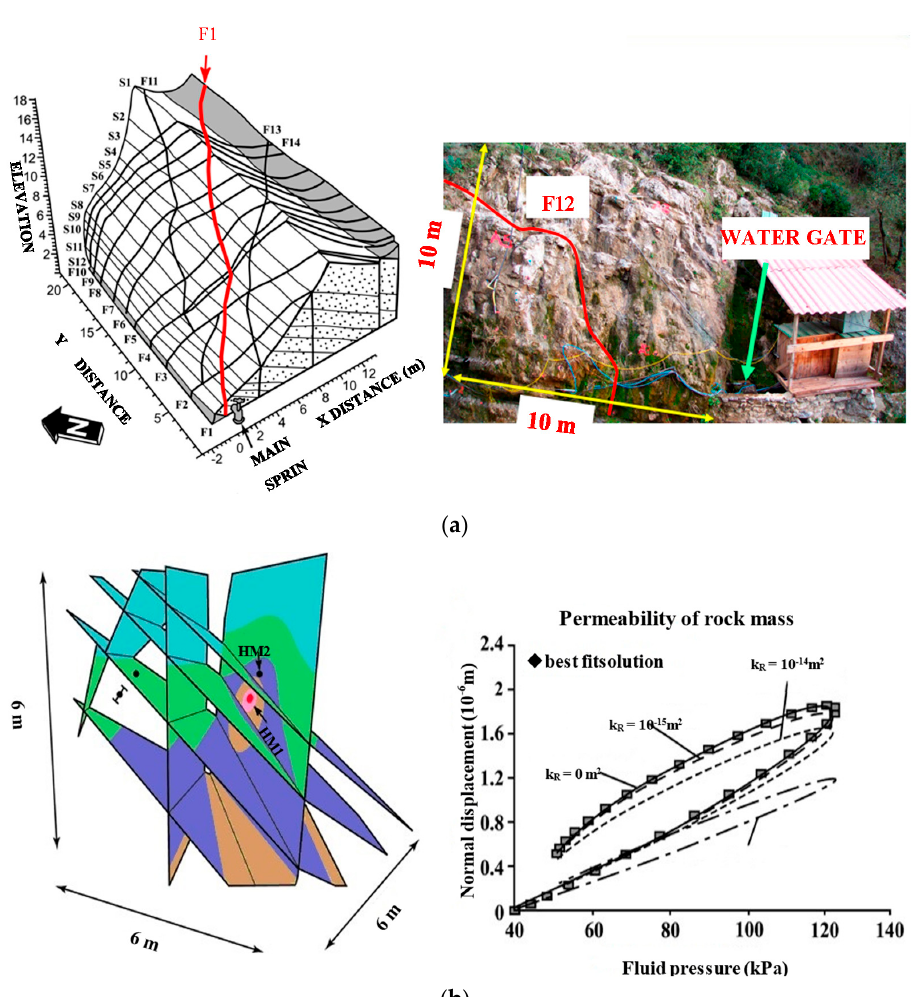
Figure 1. In situ verification test of fracture seepage ( a ) Seepage-stress coupling test site (France); ( b ) 3DEC simulation results